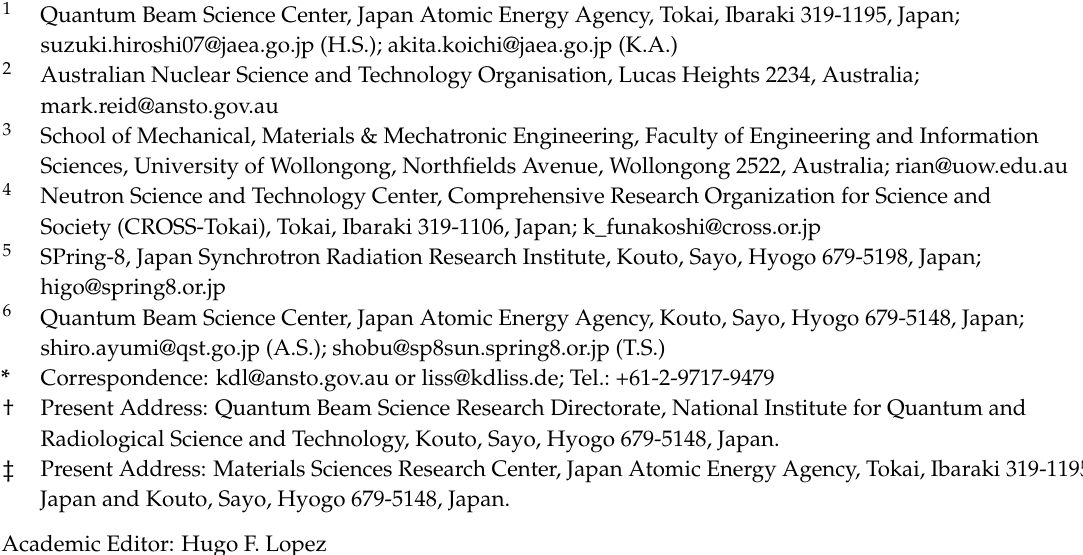
Table 1: add to caption: “ a , c in (Å); V in (Å 3 ); K 0 in (GPa).” Table 1: correct value for K 0 for α 2 to be “126” (not 116). Page 16: unit should be GPa in “With values around 146 GPa . . . ” (not